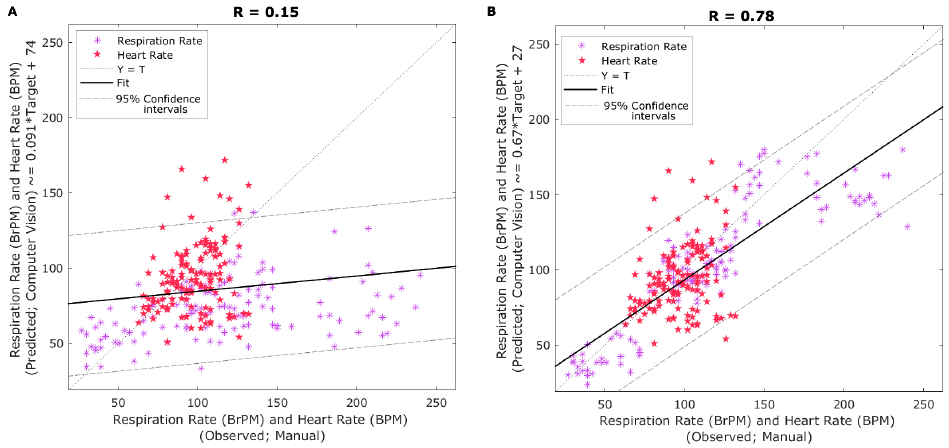
Figure 4. Linear regressions comparing results from ( A ) respiration rate (RR) and heart rate (HR) measured manually (x-axis) and using computer vision analysis with a single cutoff frequency range for respiration rate (0.33–3.1 Hz; y-axis), and ( B ) respiration rate and heart rate measured manually (x-axis) and using computer vision analysis with the corresponding cuto ff frequency range for respiration rate according to low, medium or high respiration rate (low: 0.2–1.2 Hz; medium: = 1.2–2.2 Hz; high: 2.2–3.2 Hz;